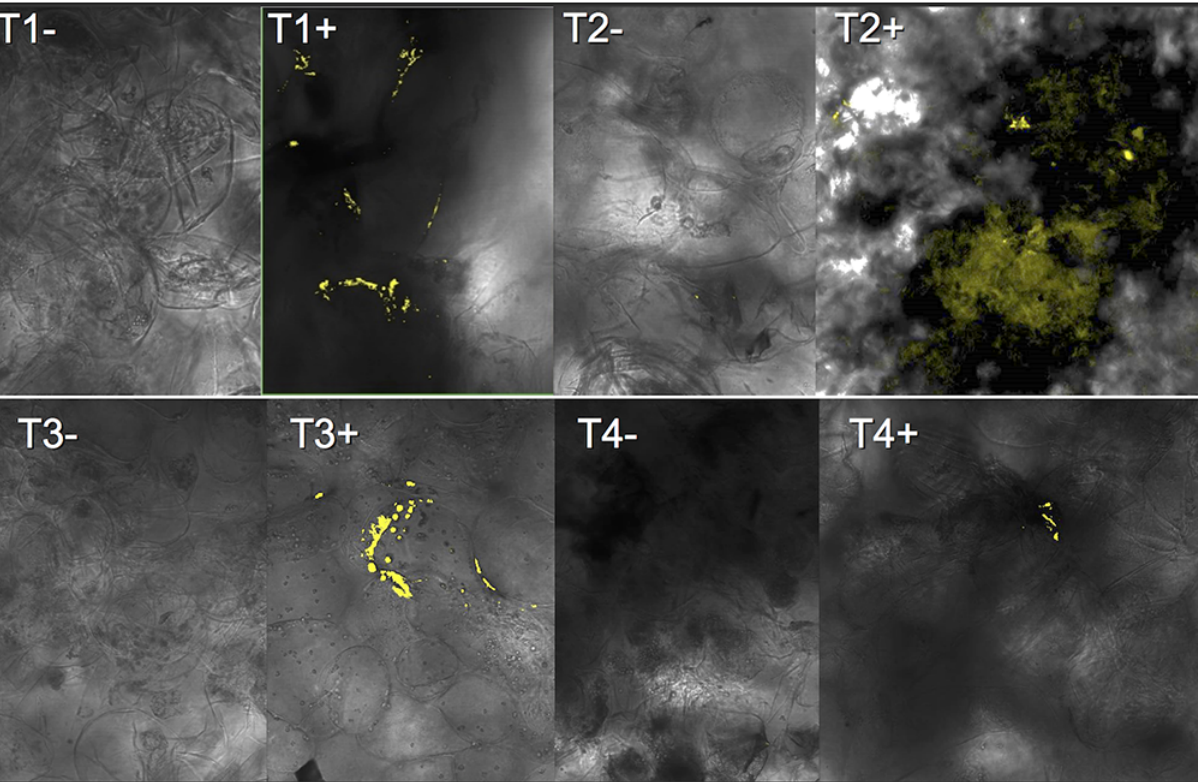
Fig. 4 Confocal microscopy images of in vitro cultured callus of C. annuum ‘Serrano’ showing the overlap of phase contrast and YFP fluorescent signal. Samples from cells growing in MS-B5 solid medium shoot once (T1+, T1−, T3+, T3−) or twice (T2+, T2−, T4+, T4−), with M5 (T1+, T1−, T2+, T2−), or M10 (T3+, T3−, T4+, T4−) microprojectiles, without (T1−, T2−, T3−, T4−) or loaded with